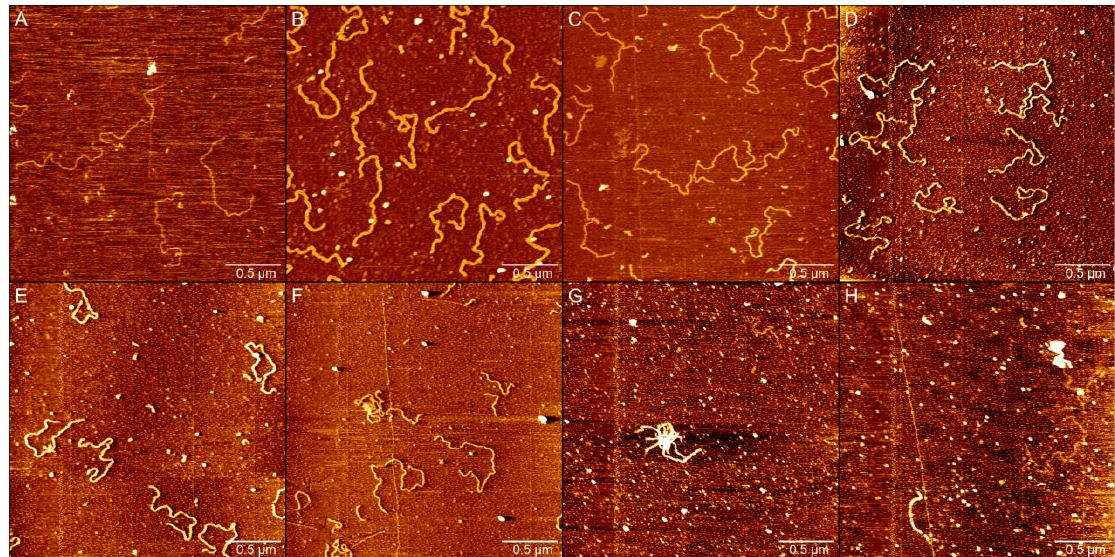
Figure 3. AFM images of 4000 bp linear DNA in deposition buffer (1 mM MgCl 2 , 10 mM HEPES (pH 7.5)) at different concentrations of PN. ( A ) Without PN. ( B – H ) The concentration of PN is 50 µM, 100 µM, 150 µM, 200 µM, 300 µM, 400 µM, 500 µM.